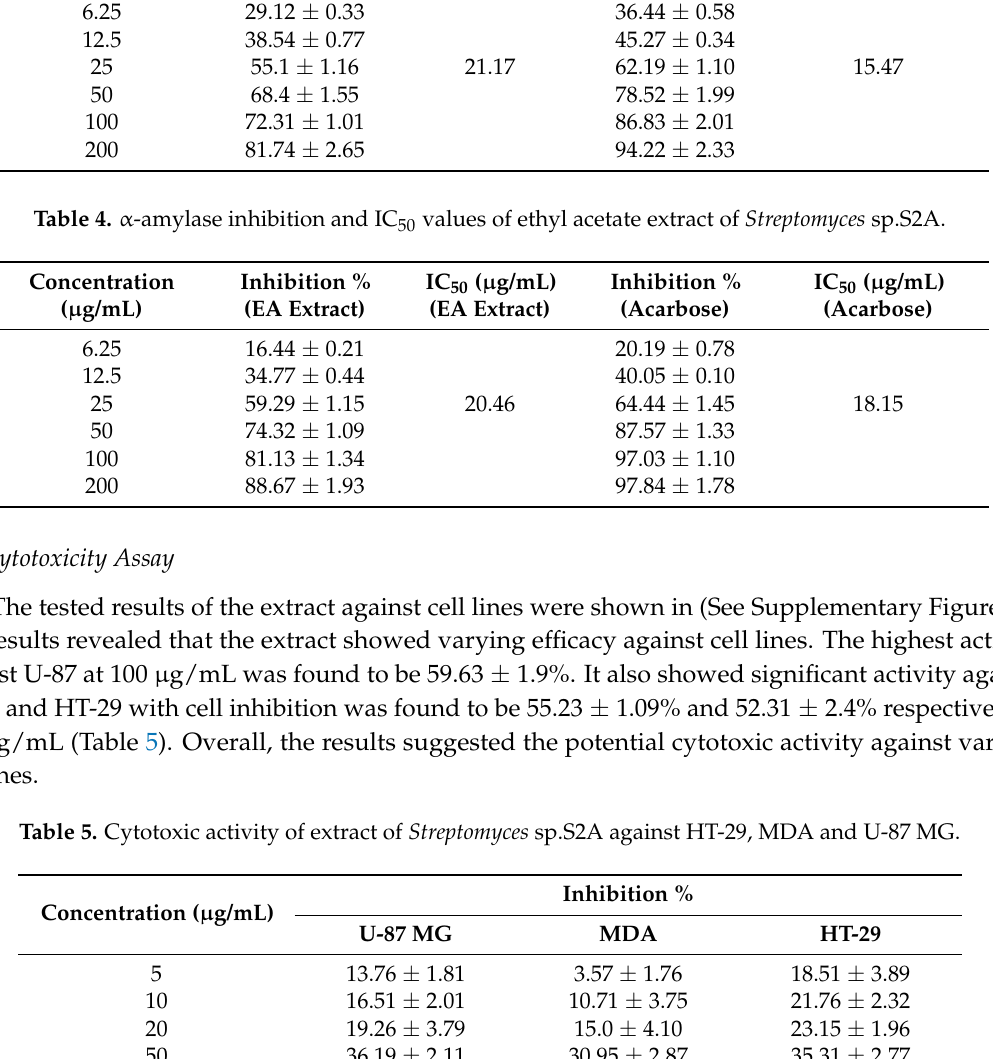
Concentration ( µ